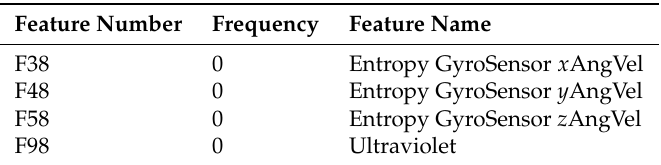
Table 7. Principal Component Analysis results for feature selection in the extended PRIDE dataset. Only removed features are